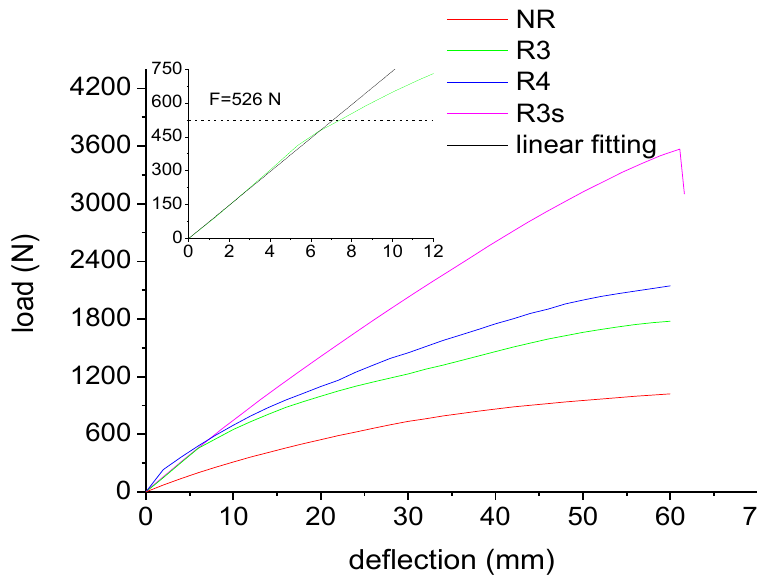
Figure 10. Load-deflection curves for plastic lumber